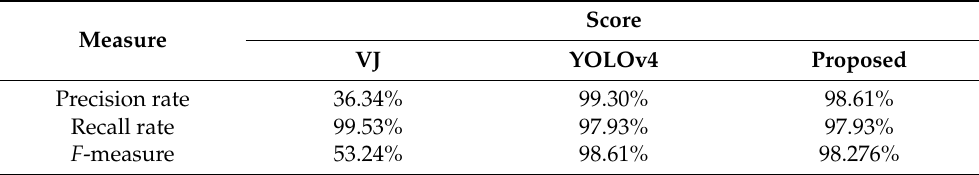
Table 2. Comparisons of detection